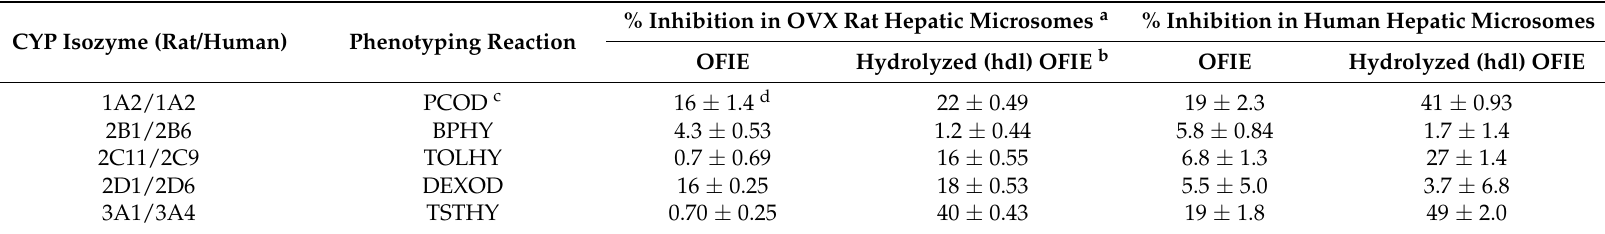
Table 1. The CYP inhibitory effects of OFIE on CYP isozyme-mediated metabolism in OVX rat and human liver microsomes a . CYP Isozyme (Rat/Human)